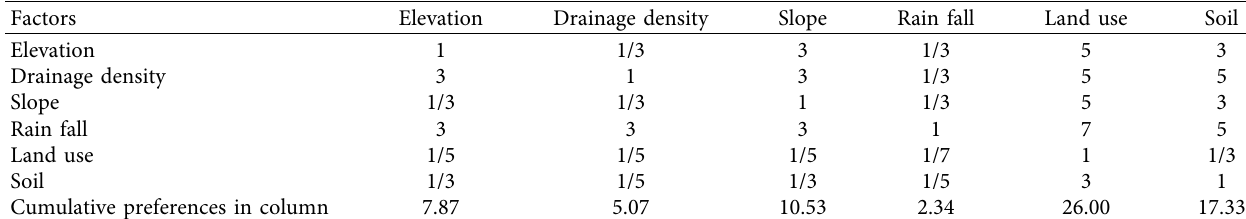
Table 3: Matrix of parameter of food hazard for AHP pair wise